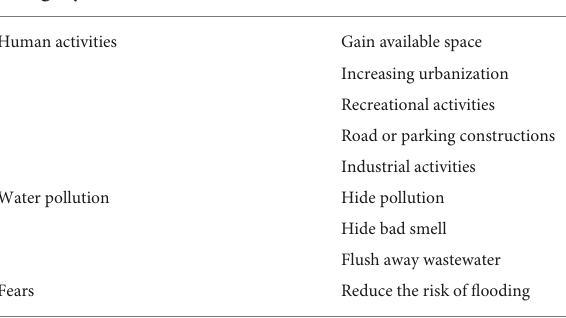
TABLE 1 Arguments that have commonly been used to justify stream burial (based on reviews by Broadhead et al., 2013; Wantzen et al.,